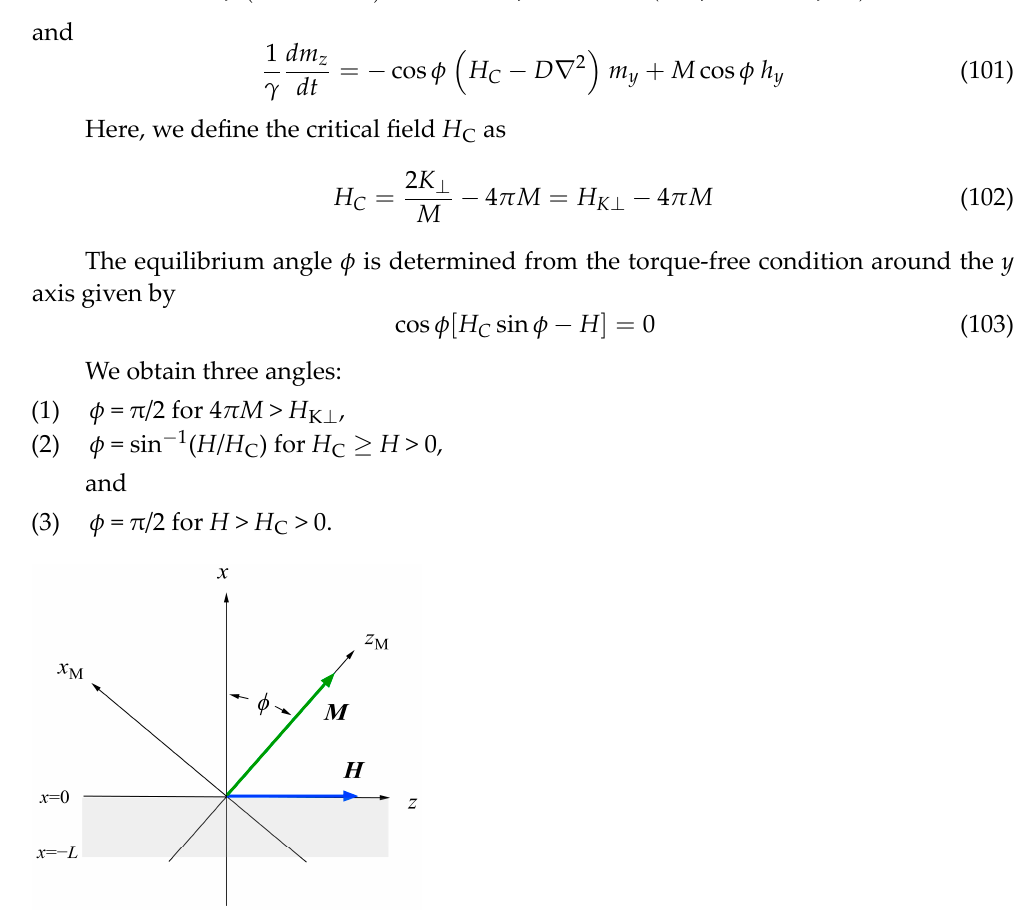
Figure 21. Schematic illustration on the magnetization rotation by the external magnetic field H ap‑ plied the in‑plane z direction ( H ≤ H C ). The equilibrium angle ϕ can be determined by Equation (103). By counterclockwise π /2‑ ϕ rotation around the y ‑axis, we can introduce the magnetization‑based co‑ ordinates ( x M , y M , z M ). In this coordinate choice, we can decouple the LL equation of motion on the z M component from the set of equations on the x M and y M